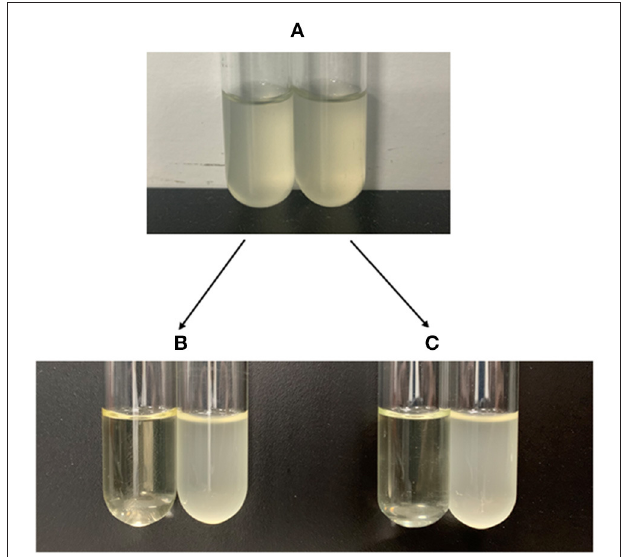
FIGURE 1 | The antibiotic susceptibility of the tetracycline-selected V. splendidus persister cells and V. splendidus cells. (A) The growth of V. splendidus exponential cells (left) and regrowth of V. splendidus persister cells (right); (B) the exponential cells of V. splendidus with (left) and without (right) 40 µ g · ml − 1 tetracycline treatment; (C) the regrown cells of V. splendidus persister cells with (left) and without (right) 40 µ g · ml − 1 tetracycline treatment.